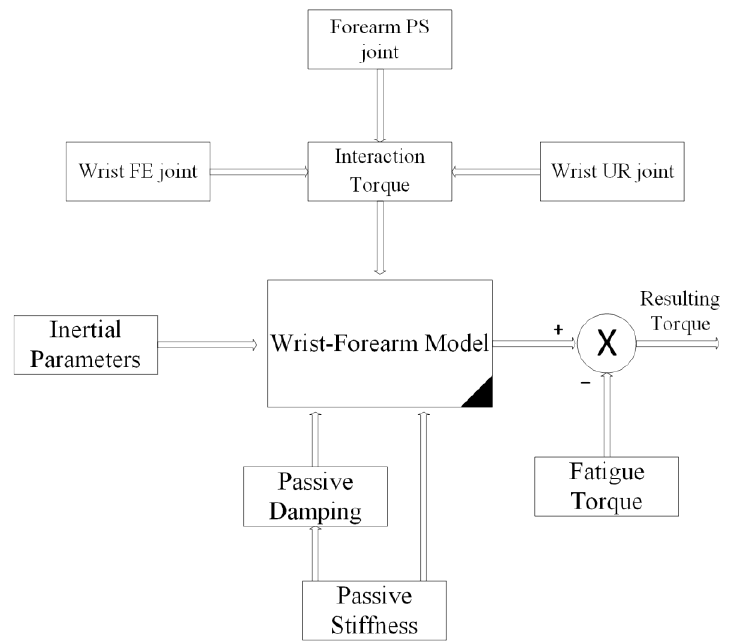
Figure 5. Wrist model and resulting torque.